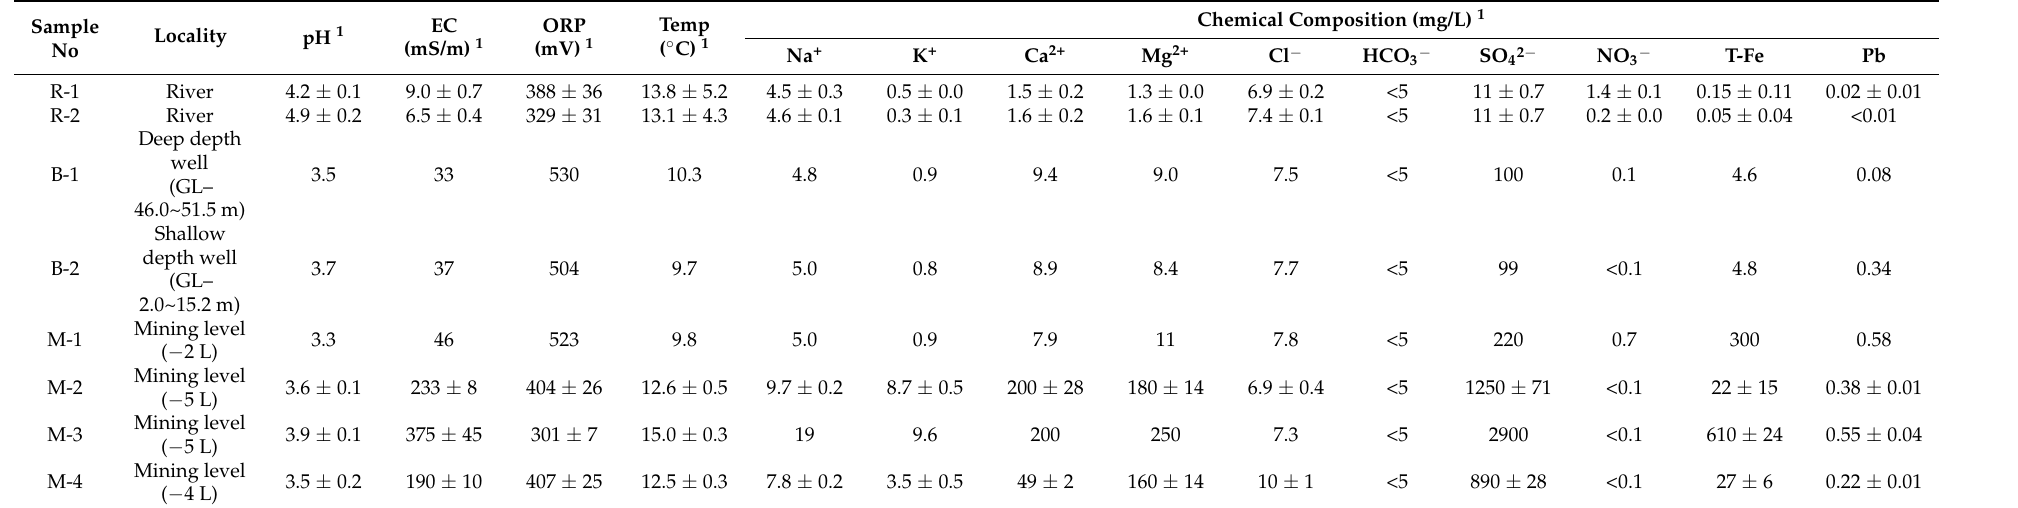
Table 6. Chemical compositions of the water